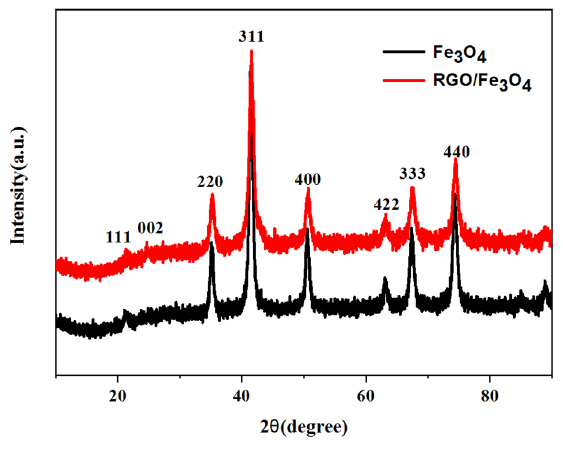
Figure 2. XRD patterns of Fe 3 O 4 nanoparticles and RGO/Fe 3 O 4 nanocomposites. In order to further determine the phase structure, the sample was analyzed by infrared spectroscopy. The FT-IR spectra of Fe 3 O 4 nanoparticles and RGO/Fe 3 O 4 nanocomposites are shown in Figure 3. Five bands at 570, 1630, 2922, 2852 and 3430 cm − 1 appear in the FT-IR spectrum of Fe 3 O 4 nanoparticles. The absorbance bands at 2852 and 2922 cm − 1 are ascribed to the v CH 2 symmetric and asymmetric stretching vibrations of oleic acid, respectively [5,17]. The peak at 570 cm − 1 could be assigned to the Fe-O-Fe stretching vibra- tions [18]. The presence of the peaks at 1630 and 3430 cm − 1 indicates that the surfaces of the nanoparticles adsorb a large number of hydroxyl groups in an aqueous environment [19].